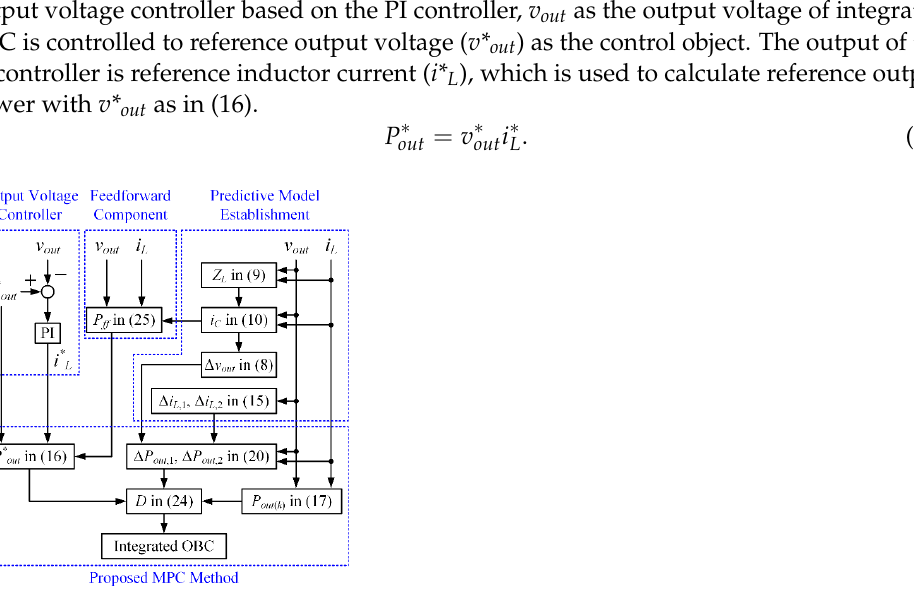
Figure 7. Control block diagram for the proposed MPC method.